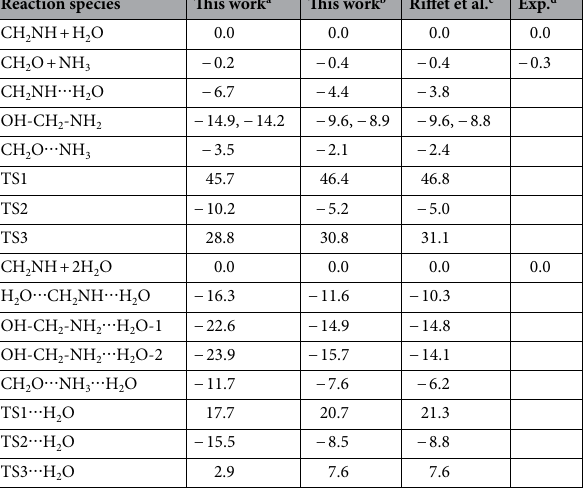
Table 1. Calculated energies (in kcal/mol) for species associated with the reaction of methylenimine with one- water and two-water molecules. a Calculated at CCSD(T)/6–311++G(3df,3pd)//M06-2X/6–311++G(3df,3pd), b Calculated at CCSD(T)/6–311++G(3df,3pd)//M06-2X/6–311++G(3df,3pd) + ZPE. c Calculated by Riffet et al. work 15 . d From ATcT data 52–54